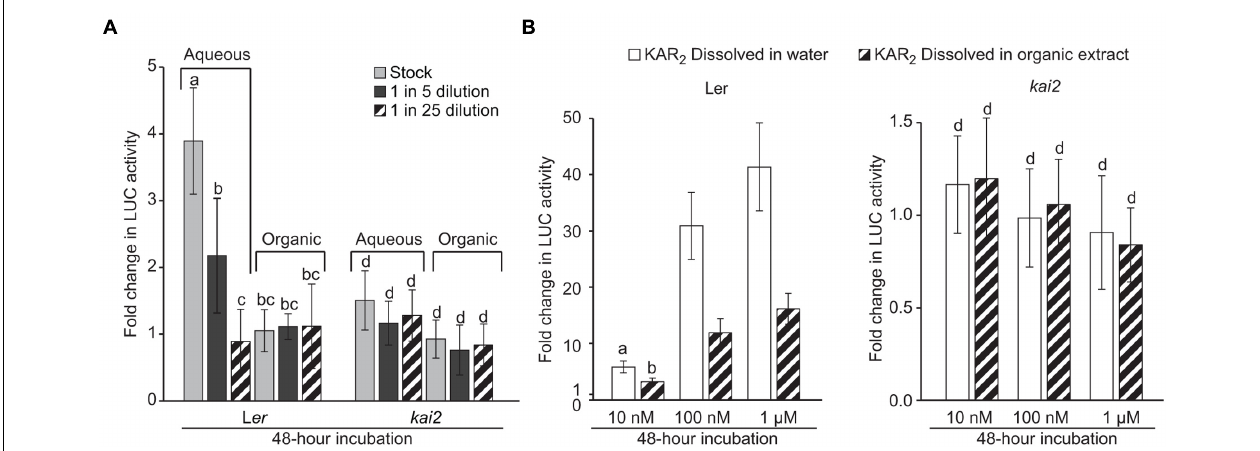
FIGURE 3 | DLK2:LUC activity is induced by Arabidopsis leaf extracts. (A) Activity of Arabidopsis leaf extracts in inducing DLK2:LUC expression in a KAI2-dependent manner. Extracts were separated into aqueous and organic fractions and applied separately. Stock treatment is equivalent to 0.2 g of rosette tissue from 7-week old Arabidopsis plants grown under an 8 h day/16 h night photoperiod. Error bars depict SE, n = 3 replicates. (B) Activity of KAR 2 standard dissolved either in water or in the organic fraction of the Arabidopsis leaf extract. The concentration of organic extract is equivalent to the stock treatment concentration in (A) . Error bars depict SE, n = 8 replicates. Shared lower case letters indicate no significant difference between treatments within the same genotype. “c” and “d” indicate no significant difference from mock-treated DLK2:LUC [L er ] and DLK2:LUC [ kai2 ] seeds, respectively. (ANOVA; P < 0.05).